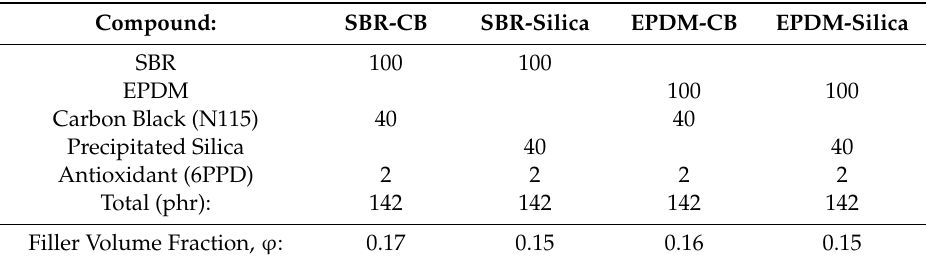
Table 1. Model formulations for particle-filled rubber compounds